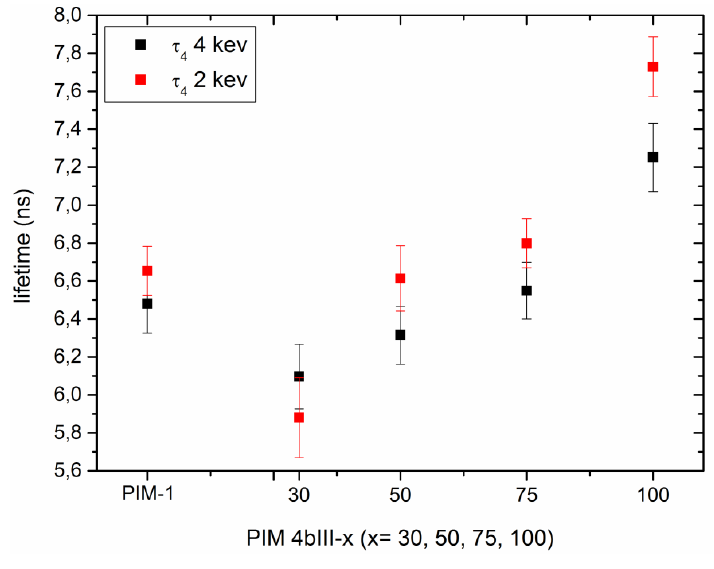
Figure 5. o-Ps lifetime as a function of polymer variants (4bIII).